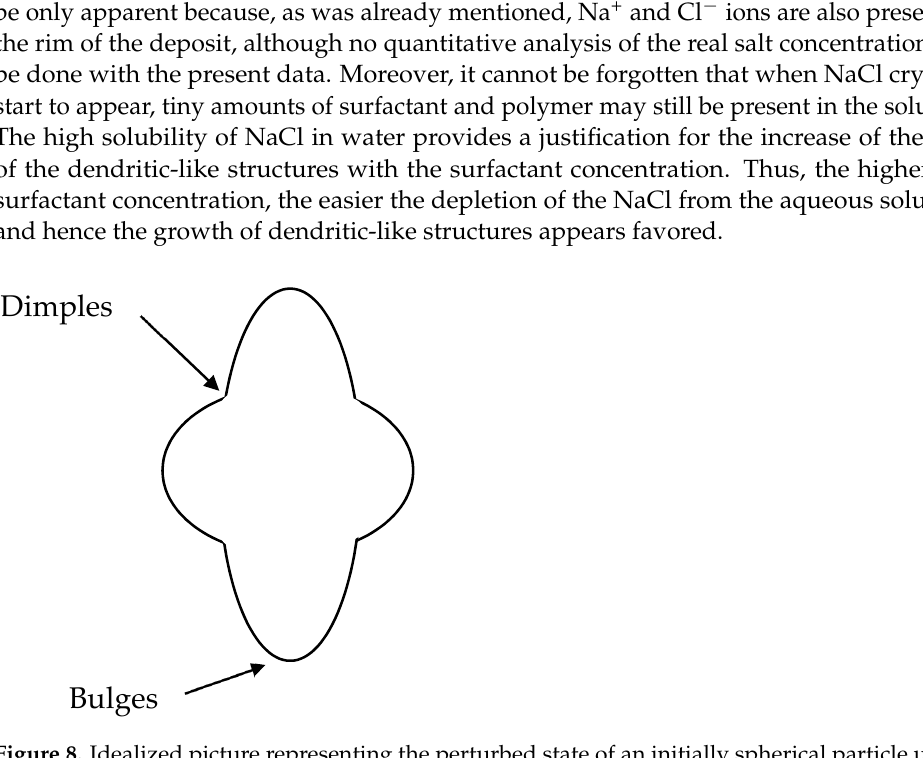
Figure 8. Idealized picture representing the perturbed state of an initially spherical particle under the influence of interfacial instabilities.